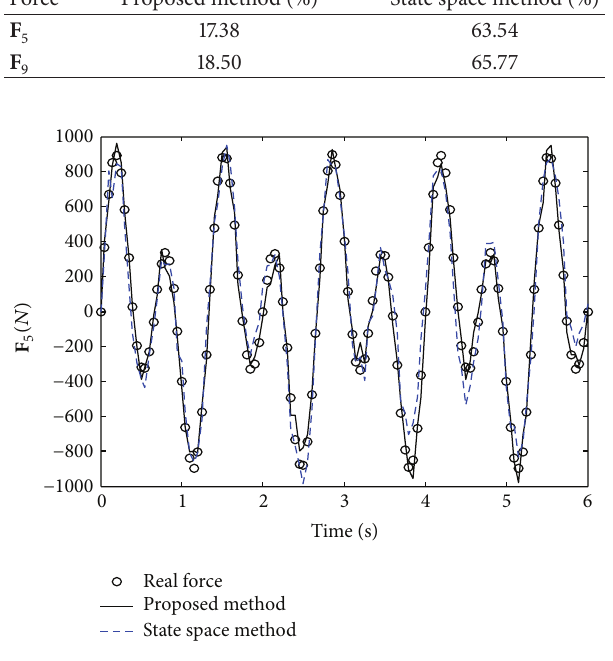
Figure 6: Force identification results of F 5 .